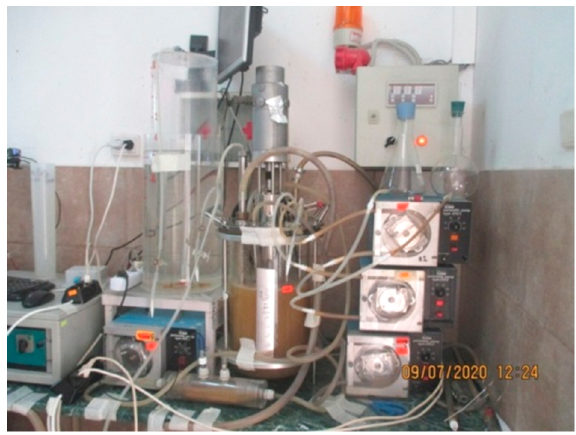
Figure 2. Hydrogen producing BR 1 with auxiliary equipment.